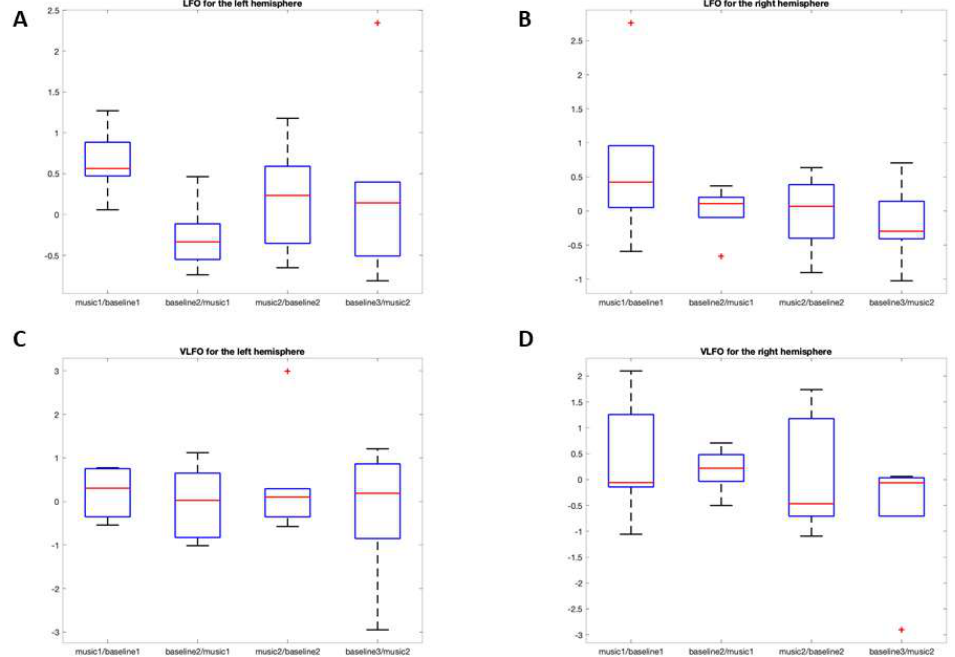
Figure A2. Boxplot showing, on the y –axis, the ratio of LFO power (low-frequency oscillation) and VLFO power (very-low-frequency oscillation) for O2HB calculated using an alternative cut–off of 0.05 Hz between LFO and VLFO; the same pattern of variations already observed with the cut–off of 0.04 Hz can be observed with this alternative cut–off. On the x –axis, the subsequent experimental blocks are shown: (m1/b1) from the first baseline to the first music period; (b2/m1) from the first music period to the second baseline; (b2/m2) from the second baseline to the second music block; (b3/m2) from the second music block to the third baseline. ( A ) Ratios of LFO power in the left hemisphere. After an increase in LFO power in m1/b1, a